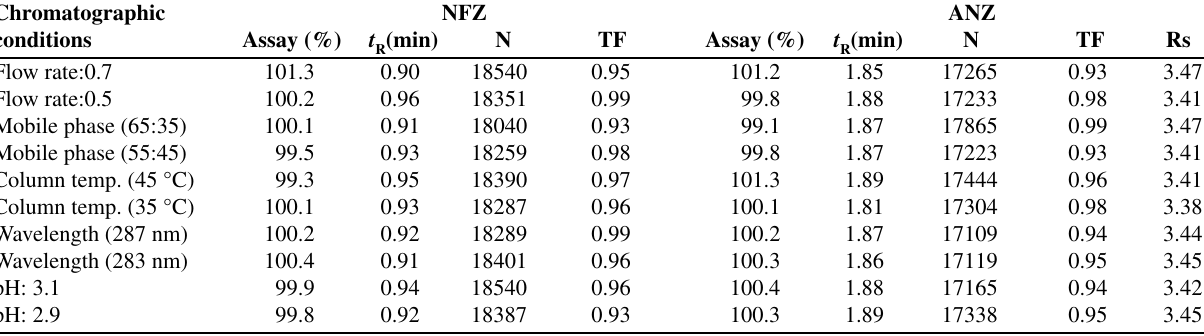
Table 7. Robustness study of ANZ and NFZ by UHPLC Chromatographic